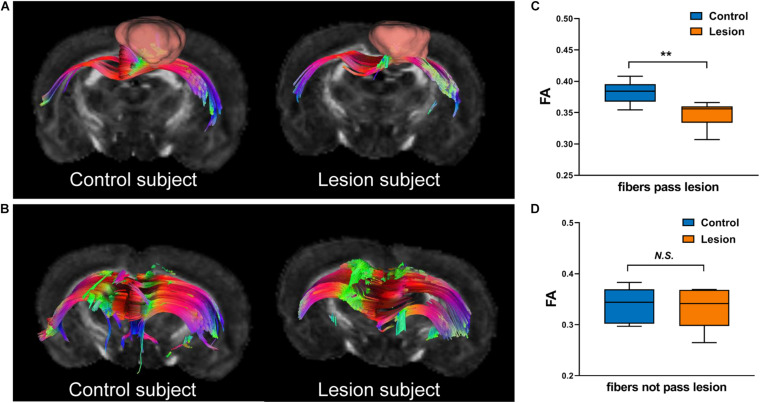
Illustration of fibers hosted by the TBSS-detected white matter regions. (A) “Direct” fibers that pass through the primary lesion (displayed with pink bulk) in the lesion group or the spatially matched ROI (displayed with pink bulk) in the control group. (B) “Indirect” fibers that do not pass through the primary lesion in the lesion group or the spatially matched ROI in the control group. (C,D) Boxplots of the FA values of direct fibers (C) and indirect fibers (D) in the control and lesion groups. Student’s t-test was performed here. **p < 0.01 and N.S.p > 0.05.